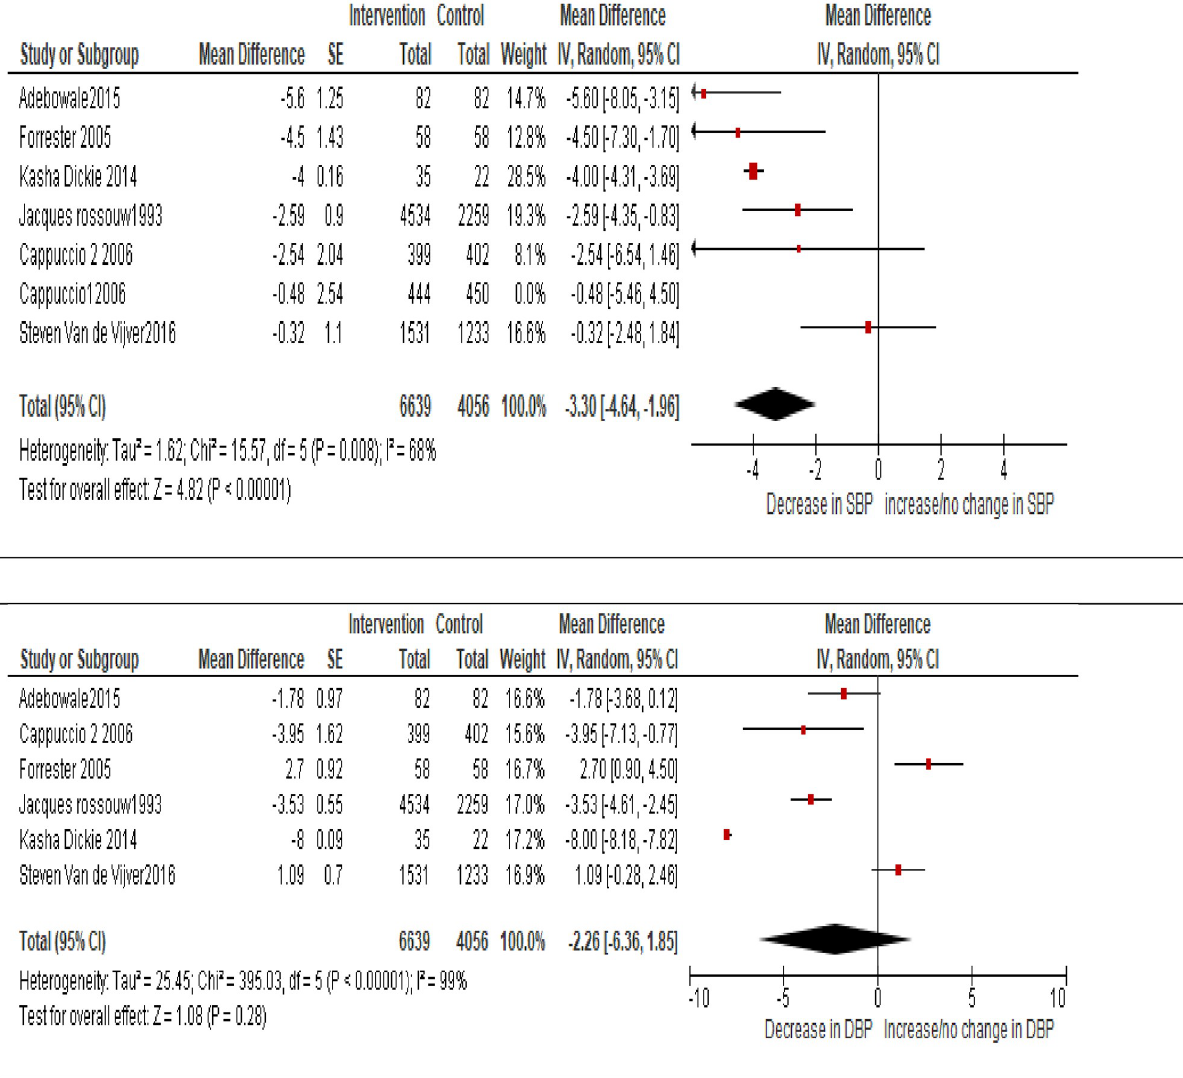
Fig 2. Forest plot showing the effect of study interventions on systolic and diastolic blood